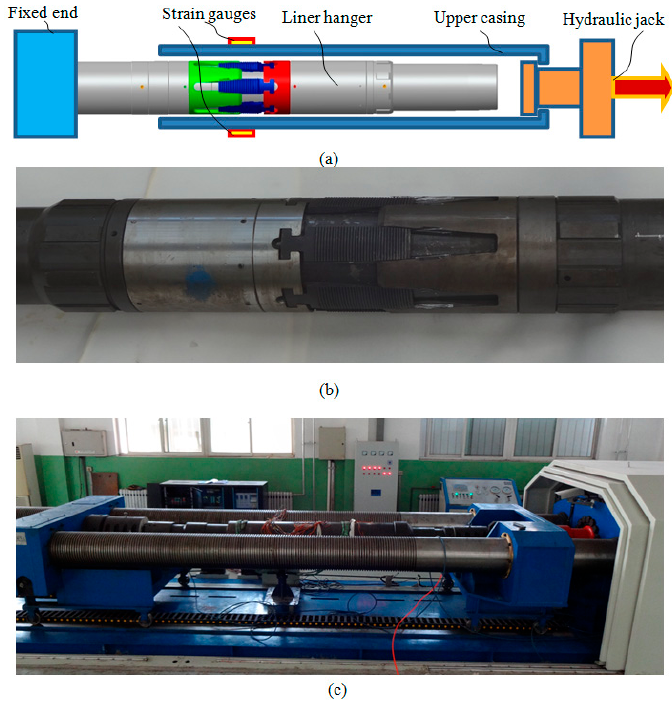
Figure 9. Experimental setup for liner hanger test. ( a ) Test device schematic diagram; ( b ) the liner hanger; ( c ) machine used to conduct the experiments.